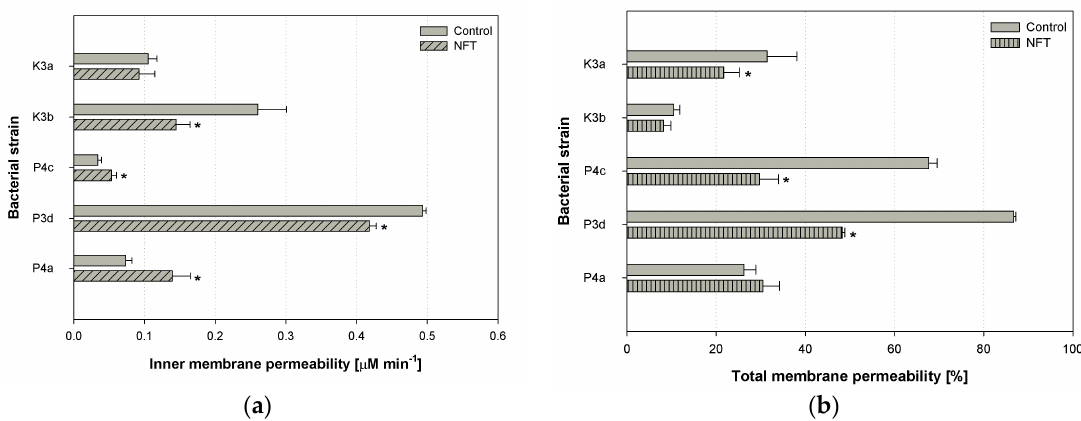
Figure 4. Changes in inner membrane permeability ( a ) and total membrane permeability ( b ) in five microbial strains subjected and not subjected to contact with nitrofurantoin; Sphingomonas paucimobilis (K3a), Ochrobactrum antrophi (K3b), Rhizobium radiobacter (P4c), Pseudomonas aeruginosa (P4a), and Sphingobacterium thalpophilum (P3d); stars (*) above the columns indicate statistical differences among groups (samples treated with nitrofurantoin (NFT) vs. untreated controls, p < 0.05, ANOVA followed by Tukey’s range test); results are reported as mean values calculated from three independent experiments.